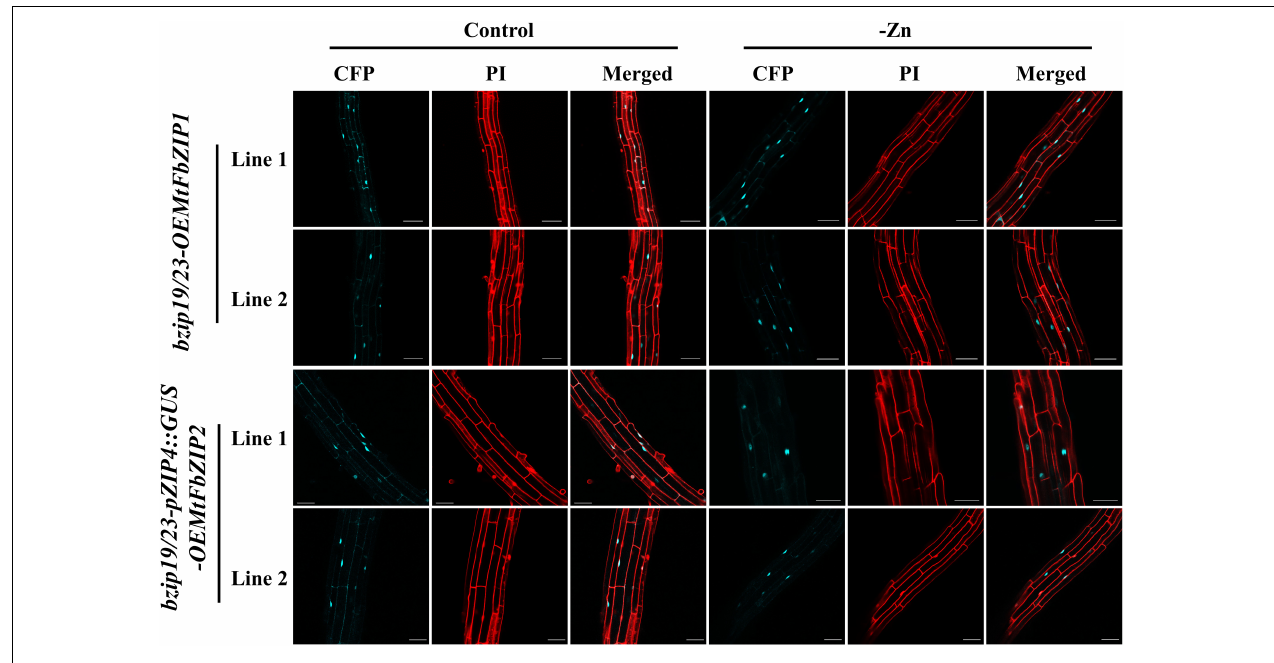
FIGURE 4 | Subcellular localization analysis of MtFbZIP1-CFP and MtFbZIP2-CFP fusion proteins in Arabidopsis roots. Two-week-old seedlings of bzip19/23-OEMtFbZIP1 and bzip19/23-pZIP4:GUS-OEMtFbZIP2 lines, grown on MS media at Zn sufficiency (Control) or Zn deficiency (–Zn) were analyzed. Emissions of CFP and propidium iodide (PI) were determined by CLSM. Two to three seedlings for each independent line were used. Scale bars = 50 µ